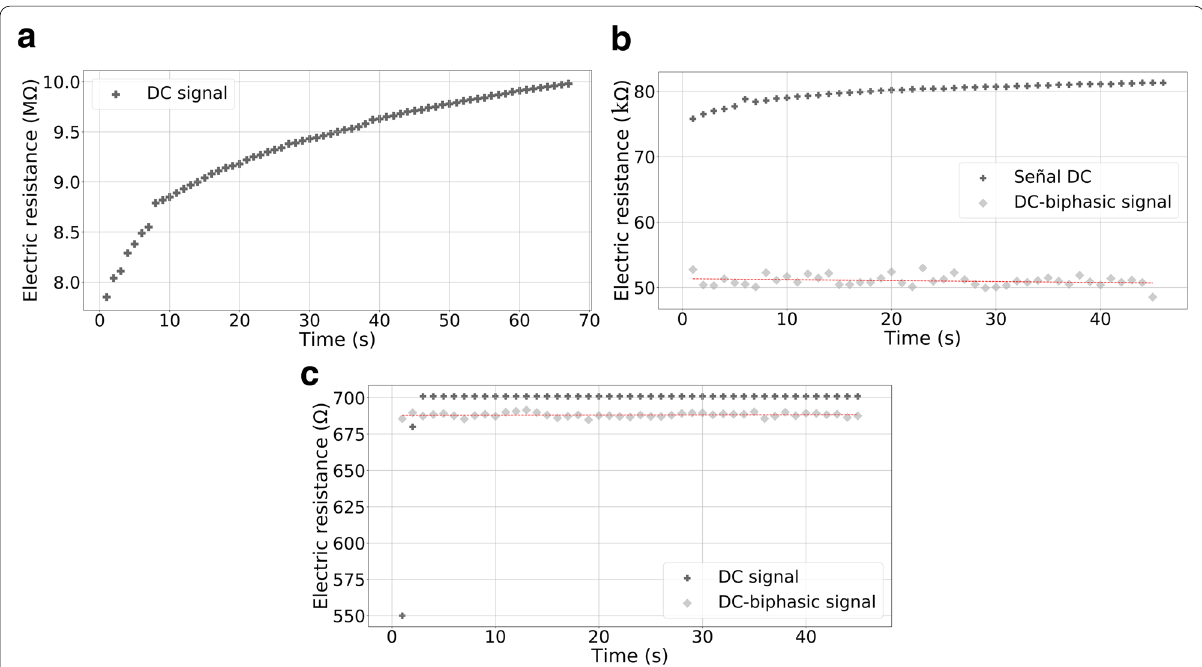
Fig. 9 Comparison using DC and BDC for samples of ( a ) 0.2 % wt of CNTs, b 0.5 % wt , and c 0.8 % wt